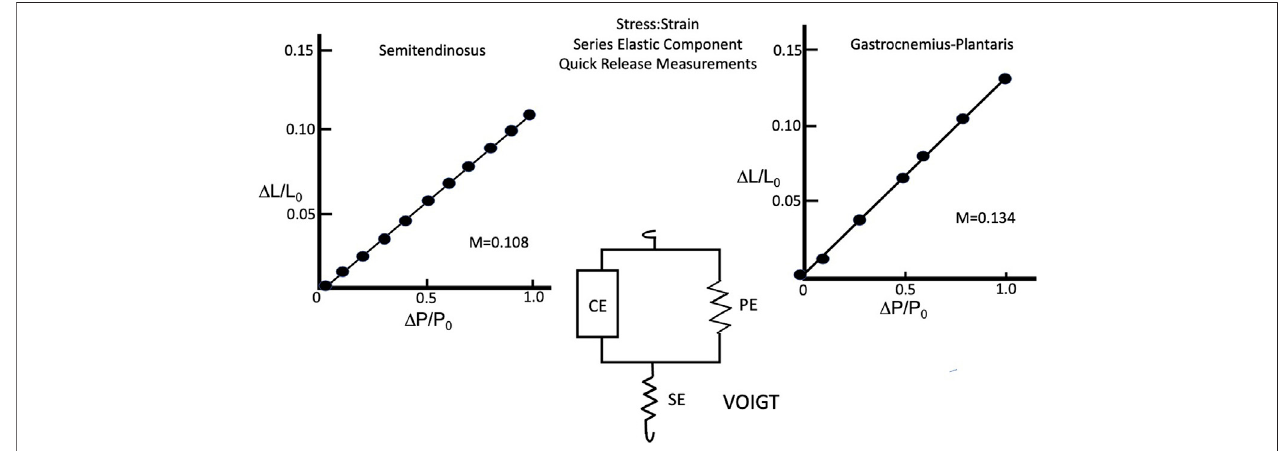
FIGURE11 | Series Elastic stress:strain relationship ofsemitendinosus (A) and gastrocnemius plantaris (B) and the Voigt model (center) describing how the series elastic and parallel elastic interact with the contractile elements.